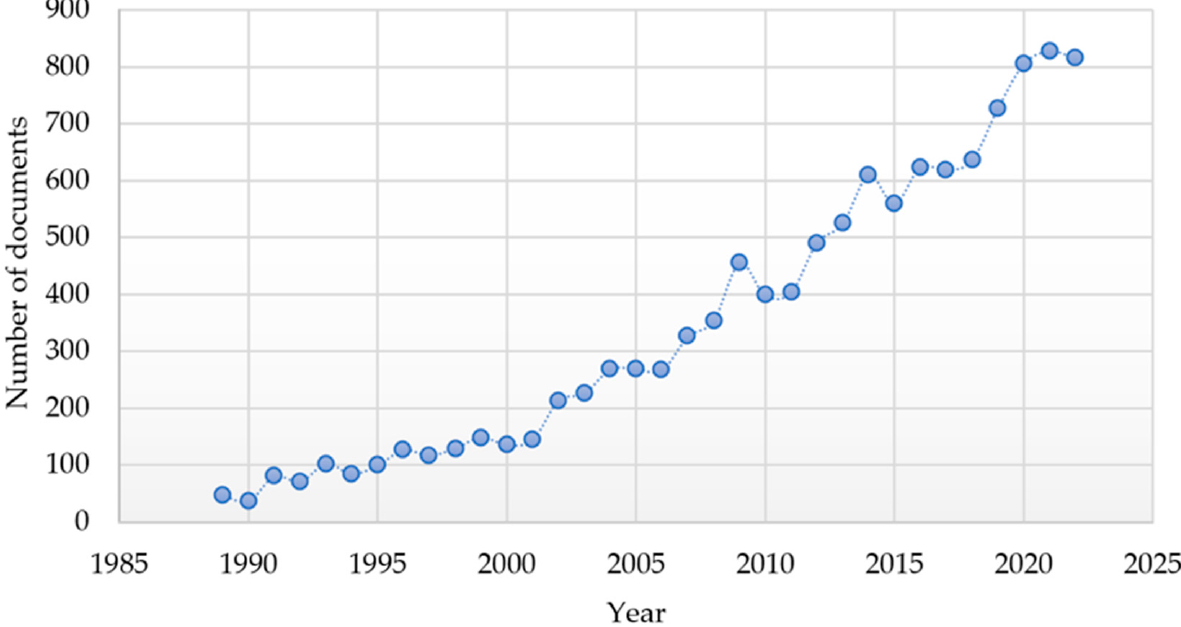
Figure 3. Analyzed search results of publications for the keywords (titan* AND implant*) and (coating* OR (surface AND modificat*)) from 1989 (the year of registration of the first patent for a titanium implant) to the present (according Scopus).